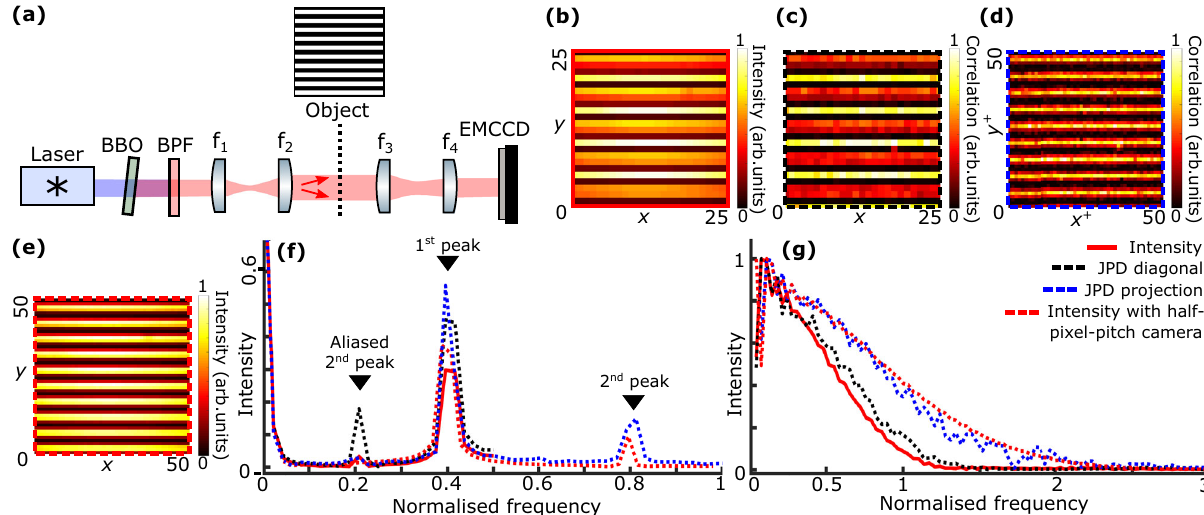
Fig. 1 Experimental demonstration of JPD pixel super-resolution. a Experimental setup. Light emitted by a diode laser (405 nm) illuminates β -barium borate (BBO) crystal with a thickness of 0.5 mm to produce spatially entangled pairs of photons by type I SPDC. Long-pass and band-pass fi lters at 810 ± 5 nm (BPF) positioned after the crystal remove pump photons. A two-lens system f 1 − f 2 images the crystal surface onto an object t , that is itself imaged onto the EMCCD camera by another two-lens system f 3 − f 4 . t is a grid-shaped amplitude object. Photon correlation width in the image plane is estimated as σ ≈ 13 μ m and camera pixel pitch is Δ = 32 μ m. b Intensity image, ( c ) JPD diagonal image and ( d ) sum-coordinate projection of the JPD. e Intensity image obtained using a camera with half pixel pitch i.e. 16 μ m. All images show the same spatial region of the object containing 10 grating periods. Coordinates are in pixels. f Spectra of the intensity image (solid red), diagonal image (dashed black), JPD sum-coordinate image (dashed blue) and intensity image acquired with a 16 μ m-pixel-pitch camera (dashed red) obtained by performing a discrete Fourier transform to the corresponding image and averaging over the x -axis. g System modulation transfer function (MTF) obtained using the slanted-edge technique with an intensity image (solid red), a diagonal image (dashed black), a JPD sum-coordinate image (dashed blue) and an intensity image acquired using a 16 μ m-pixel-pitch camera (dashed red). All frequency values are normalized to the same reference frequency k 0 = 1/ Δ